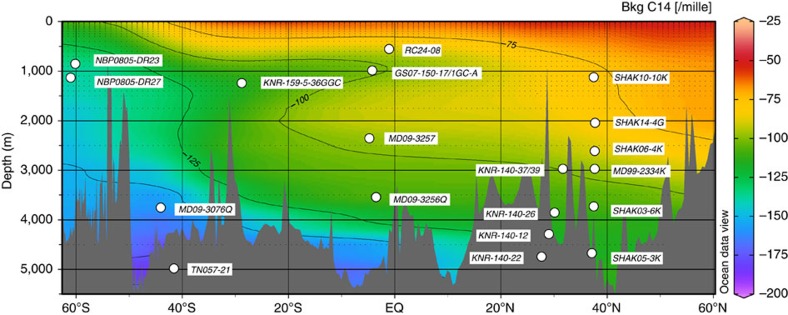
Map of core locations.Map showing core/dredge locations with modern background Δ14C (GLODAP38), using Ocean Data View71.